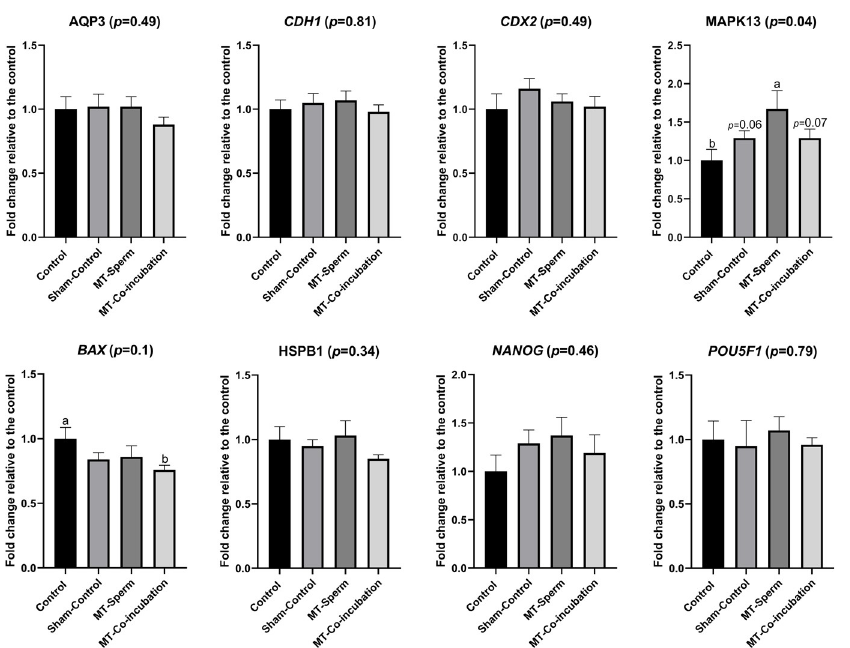
Fig 2. Relative mRNA abundance of genes related to embryo developmental pathways in expanded blastocysts derived from sperm treated or not with melatonin in the IVF protocol. Cadherin 1 ( CDH1 ), caudal type homeobox 2 ( CDX2 ), the regulator of MAP kinase activity (MAPK13), water transport gene aquaporin 3 ( AQP3 )], apoptosis regulation [BCL2 Associated X, Apoptosis Regulator ( BAX ), and Heat shock protein beta-1 ( HSPB1 )], and pluripotency [POU domain, class 5, transcription factor 1 ( POU5F1 ), and the Nanog Homeobox ( NANOG )] in the in vitro -derived expanded blastocysts. Data are represented as fold change relative to the control after normalizing the geometric mean from the housekeeping genes (Globin/ GAPDH ) and are means ± SEM. Different letters (a-b) indicate significant differences amongst experimental groups ( P < 0.05). Percentages with p values above the SEM show statistical trends, whereas p values enclosed within parenthesis refer to significance level found in the statistical model for each evaluated